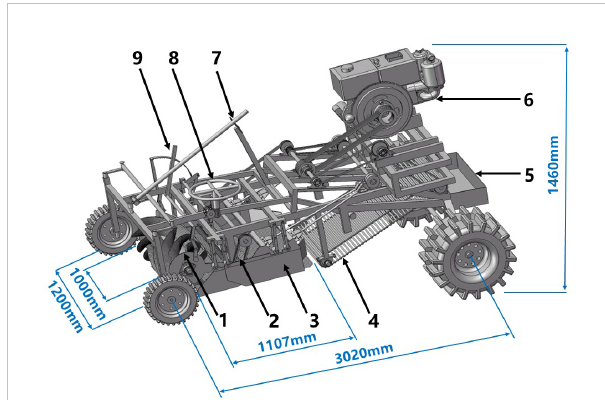
FIGURE 1 Structural diagram of the shell fi sh vibrating harvester. 1. First-stage brush; 2. Second-stage brush; 3. Crank rocker double-layer vibrating screen; 4. Conveying chain; 5. Shell fi sh collection basket; 6. Power system; 7. Steering device; 8. Catch depth adjustment handle; 9. First-stage brush adjustment